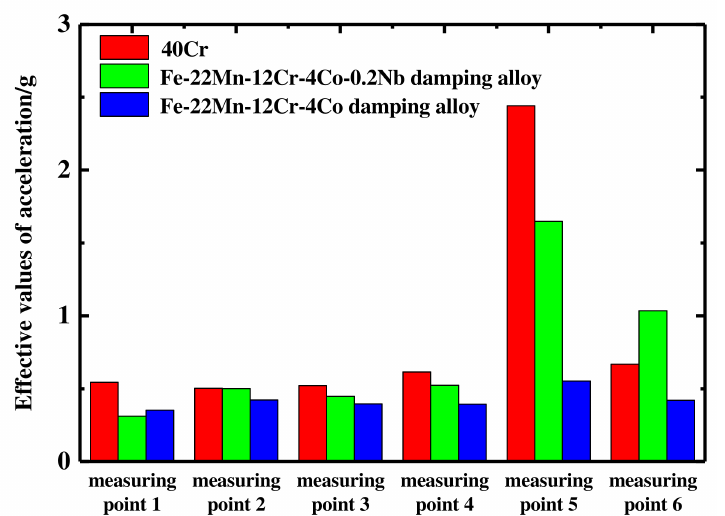
Figure 20. Comparison of effective values of vibration acceleration of different gear materials under 700 rpm and 10 N · m working